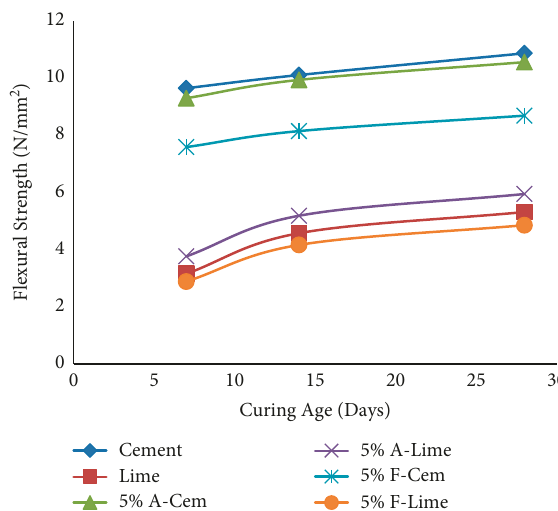
Figure 5: Flexural strength of bagasse ash concrete at 5% replacement.